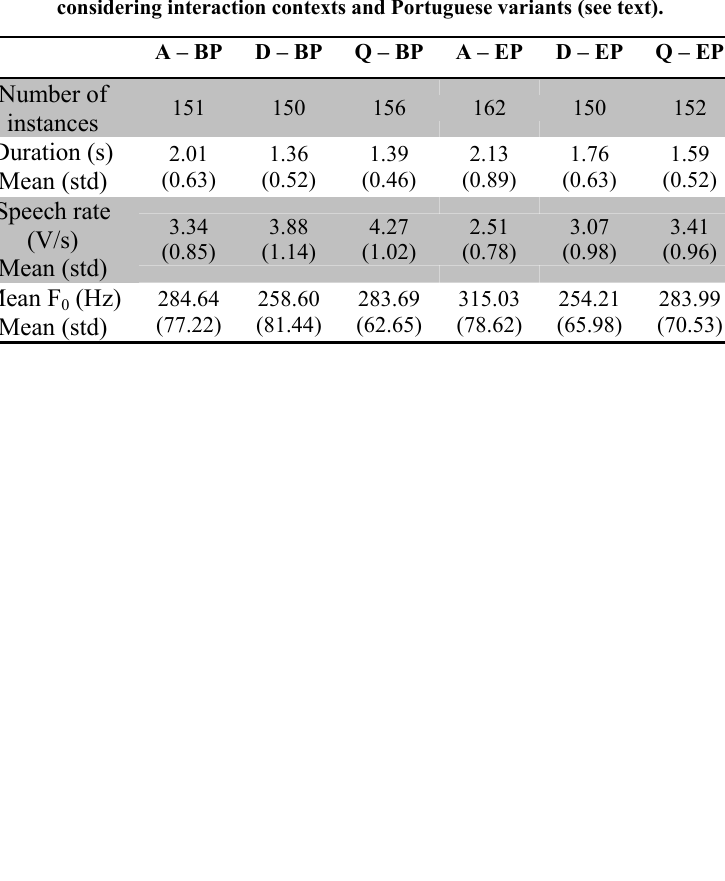
Table IX: Basic statistical information about the speech utterances grouped by classes considering interaction contexts and Portuguese variants (see